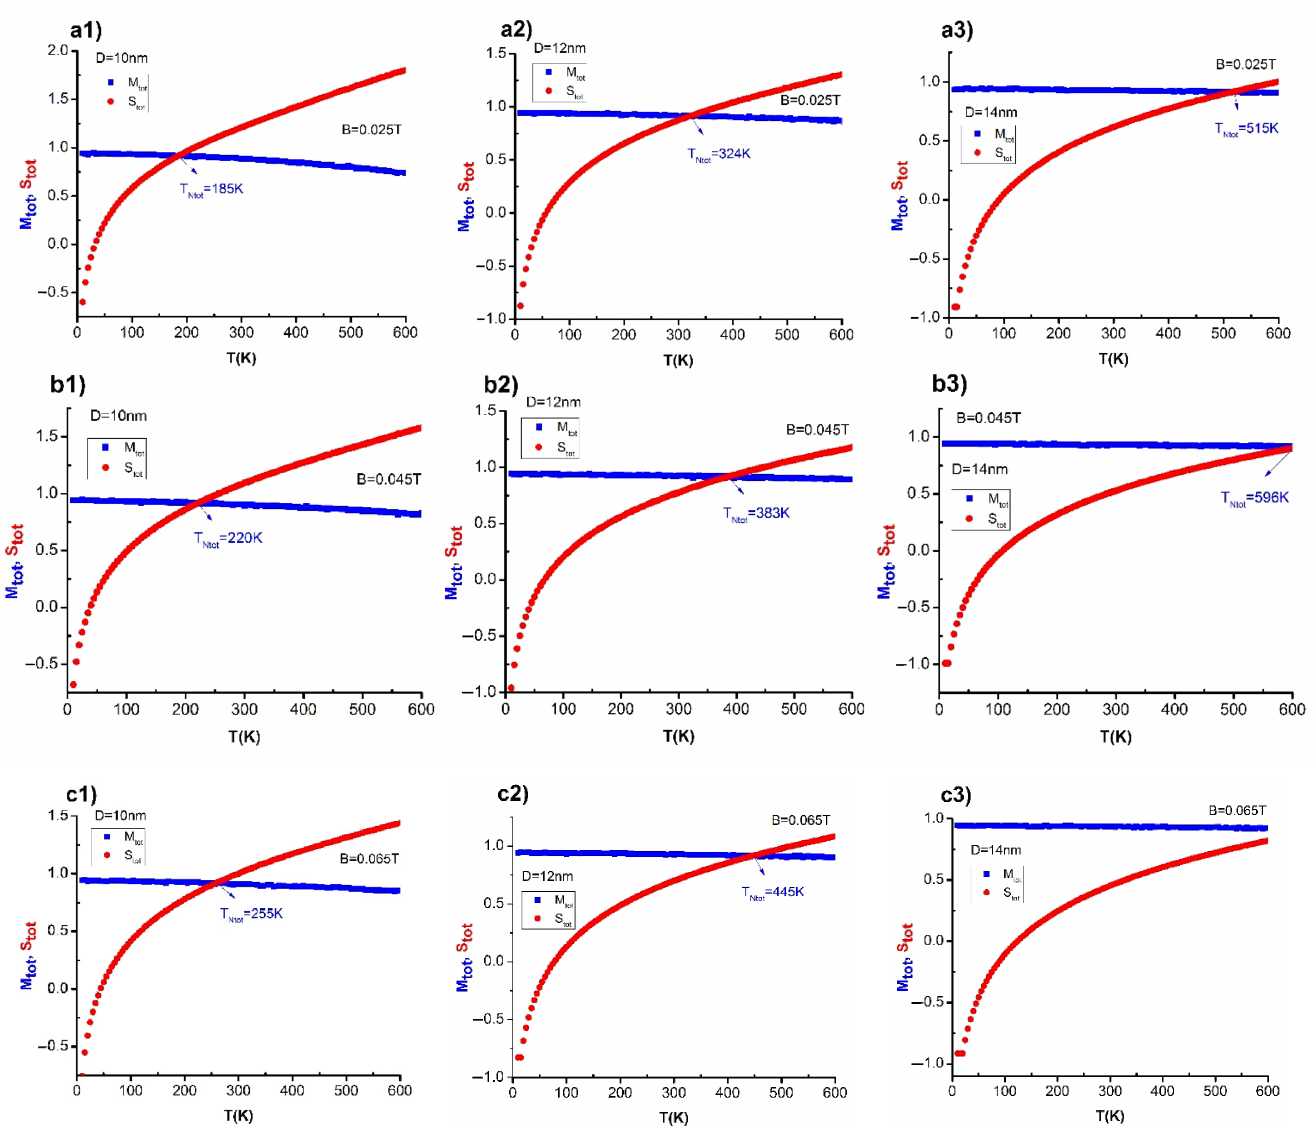
Figure 7. Néel phase transition temperature (T Ntot ) of Fe 2 O 3 nano synthetic thin film mxm = 20 × 20, in B = 0.1 T with rotation angle α = 90°, for D = 10 nm and different values of B, B = 0.025 T ( a1 ), B = 0.045 T ( b1 ), B = 0.065 T ( c1 ); for D = 12 nm and different values of B, B = 0.025 T ( a2 ), B = 0.045 T ( b2 ), B = 0.065 T ( c2 ); for D = 14 nm and different B, B = 0.025 T ( a3 ), B = 0.045 T ( b3 ), B = 0.065 T ( c3 ).